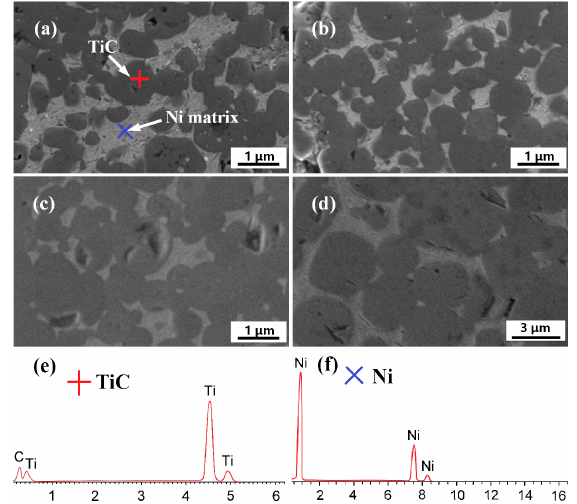
Figure 5. SEM micrographs of sintered green bodies in DTA instrument with different heating rates: ( a ) 5 °C/min; ( b ) 20 °C/min; ( c ) 40 °C/min; and ( d ) 80 °C/min; ( e , f ) The energy-dispersive spectrometry (EDS) spectra of TiC and Ni, respectively.